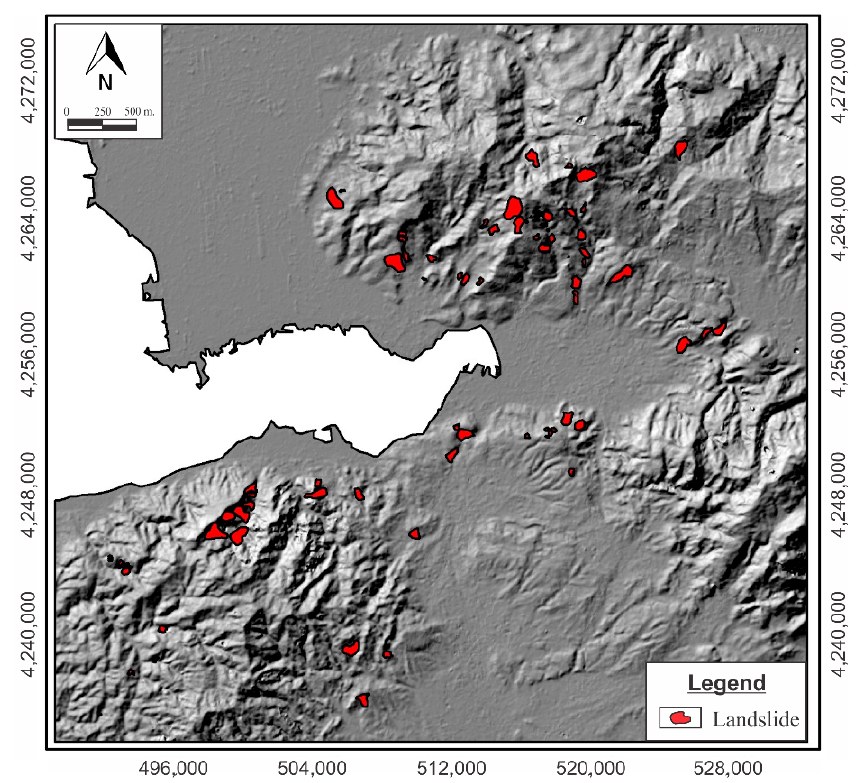
Figure 3. Landslide inventory map of the study area.